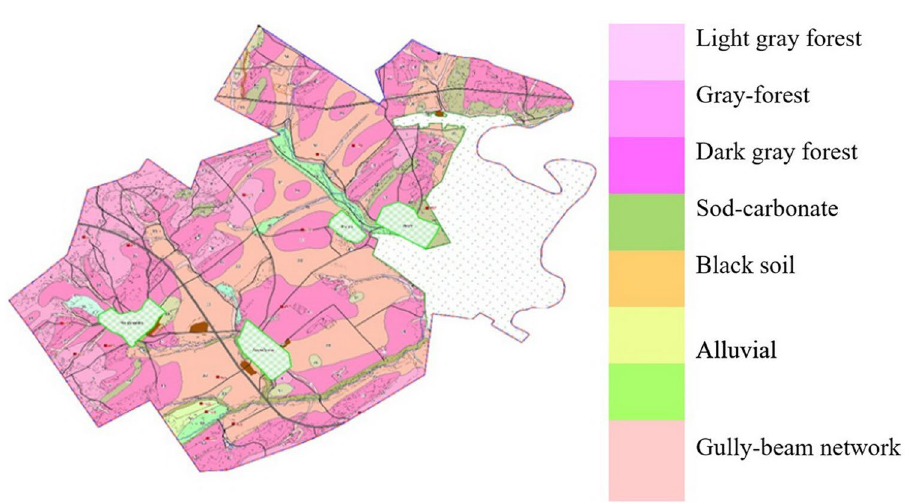
Figure 6. Completed soil map within the boundaries of the Salavat district of the Republic of Belarus,